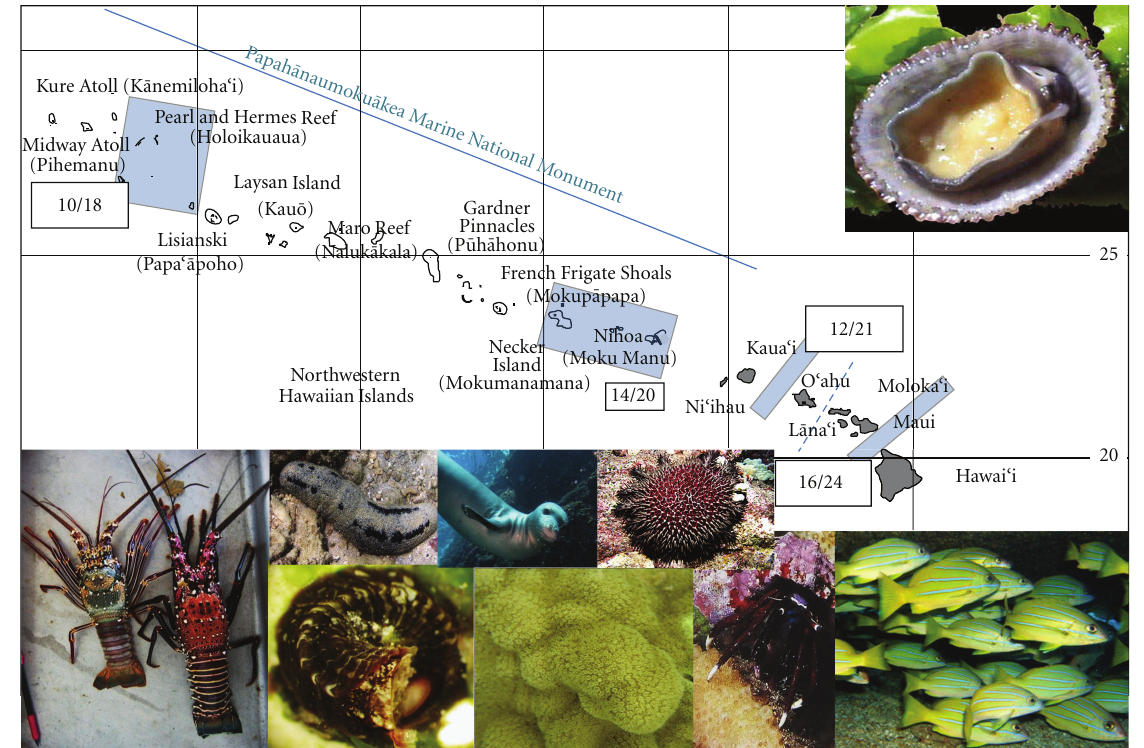
Figure 2: Map of the Hawaiian Archipelago with significant consensus genetic breaks among the 27 taxa listed in Table 1 overlaid as blue bars between islands. In each bar, the number of species that show evidence for restricted gene flow across the barrier is listed in the numerator, and the total number of species for which we have data across that geographic area is listed in the denominator. The total number of sites included for each species is variable because not all species have been collected or analyzed at each site. The dotted line between Maui Nui and O‘ahu highlights the location of the barrier that is shared by 8 of the surveyed species but is not significantly di ff erent than random expectations. The images include some of the species included in these analyses (left to right): Panulirus penicillatus, Panulirus marginatus, Holothuria atra, Dendropoma rhyssoconcha, Monachus schauinslandi, Porites lobata, Acanthaster planci, Calcinus hazletti, Lutjanus kasmira, and Cellana sandwicensis (photo credits to Derek Smith, Joe O’Malley, and the